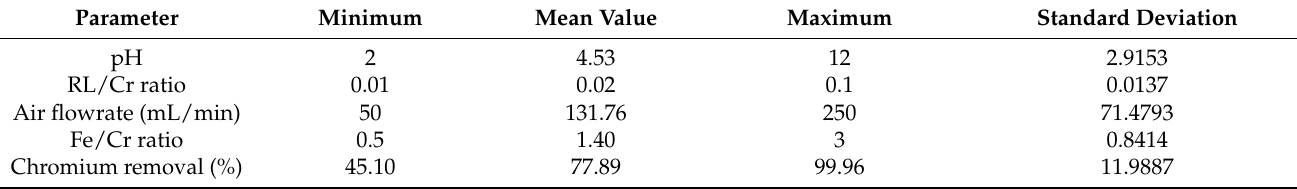
Table 2. The statistical summary of the data used in ANN